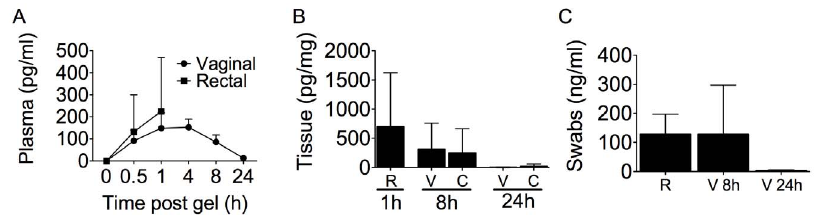
Figure 3. MIV-150 local and systemic levels after vaginal and rectal application . Macaques were treated vaginally with MZC daily for 2 wks or once rectally. A) MIV-150 was measured by LCMS/MS in the plasma of vaginally (n=6, filled circles) and rectally (n=6, filled squares) treated macaques at various time points after the last gel application. B) Tissue biopsies (n=12 per time point/type of tissue) and C) swabs (n=6 per condition) were collected at the indicated times following the last gel and MIV-150 was measured (by LCMS/MS for tissues and RIA for swabs). The mean ( 6 SD) concentrations of MIV-150 for each treatment group are shown (rectal, R; vaginal, V; cervical, C).